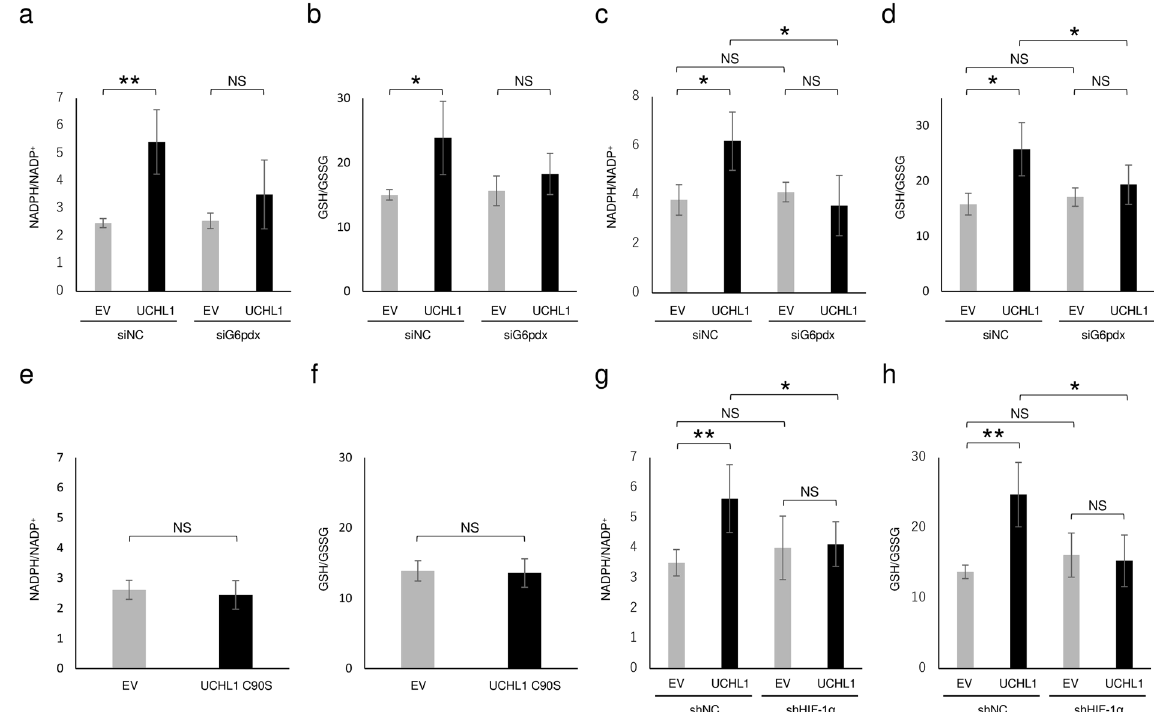
Figure 3. Antioxidant levels in UCHL1-overexpressing murine breast cancer EMT6 cells. ( a – h ) EMT6 cells transfected with the indicated expression vector for none (EV; a – h ), UCHL1 ( a – d , g , h ), or UCHL1 C90S ( e , f ), or for shRNA against HIF-1 α (shHIF-1 α ; g , h ) or scramble shRNA (shNC; g , h ), or with the indicated siRNA for G6pdx (siG6pdx; a – d ) or scramble siRNA (siNC; a – d ) were subjected to quantitative analyses of the ratio of NADPH to NADH + ( a , c , e , g ) and GSH to GSSG ( b , d , f , h ) using the NADP/NADPH Quantification